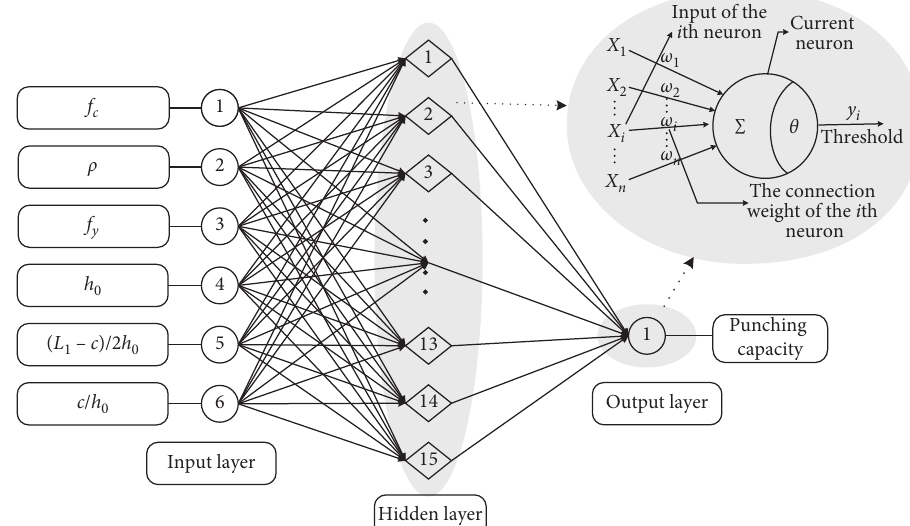
Figure 1: Topological structure of the BPNN model.